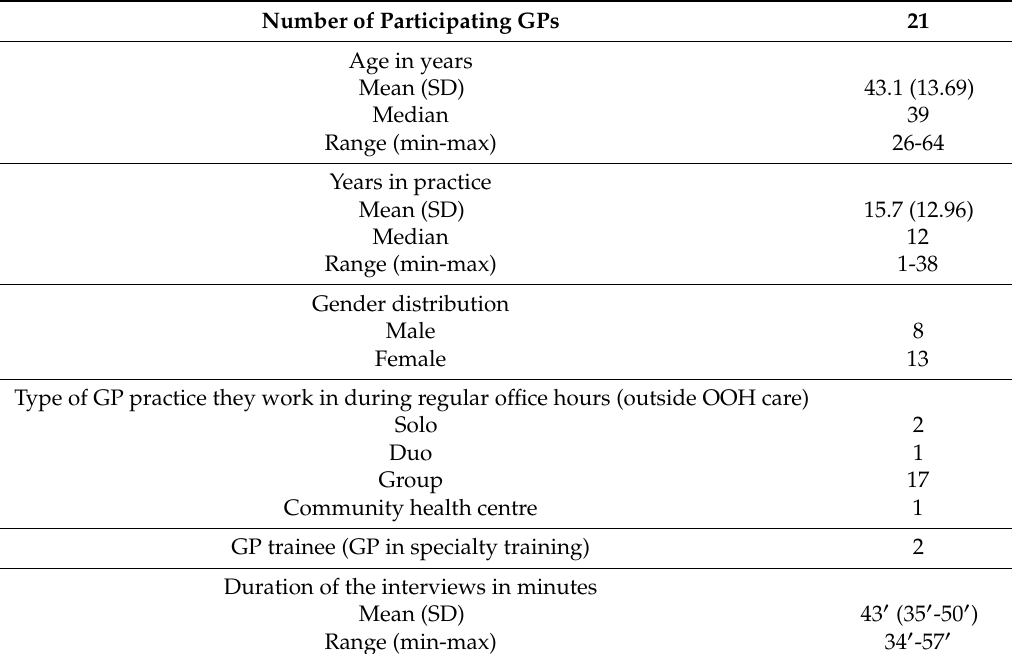
Table 1. Characteristics of the general practitioners (GPs)